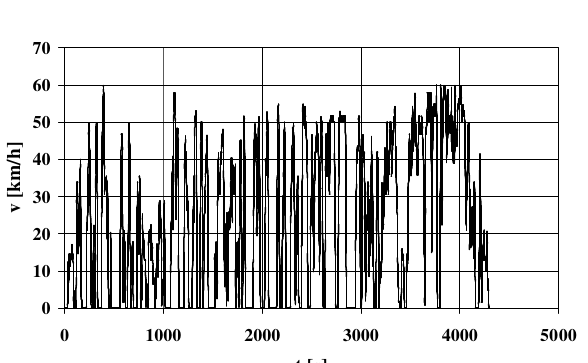
Fig. 4. Speed curve – v in the RDE test cycle performed with a Fiat Idea [1]